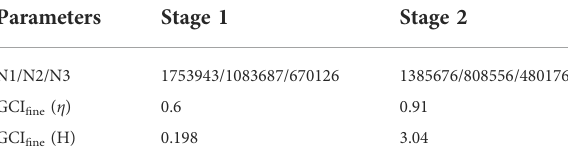
TABLE 2 Calculation of GCI values for the 2 stages.